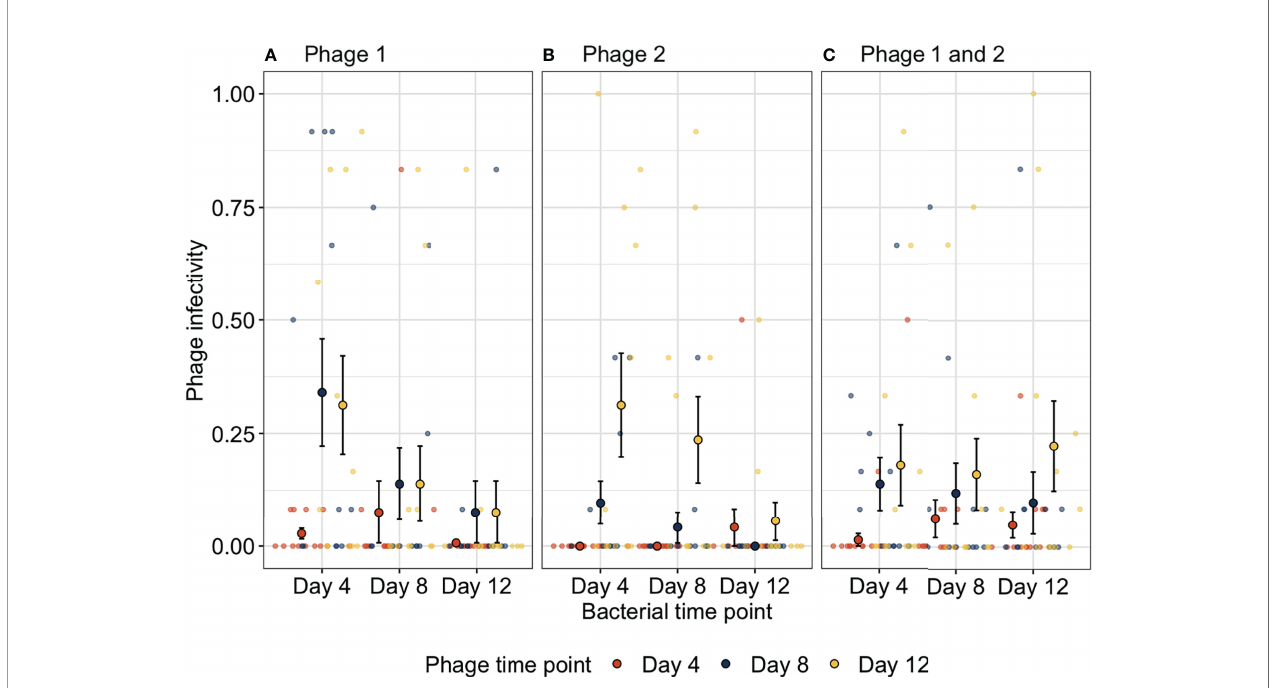
FIGURE 2 | Changes in phage infectivity to bacteria isolated from three different time-points over bacteria-phage coevolution. In the presence of (A) strain one or (B) strain two, bacteria coevolved with phage with increasing bacterial resistance and phage infectivity through time (arms-race coevolution). In contrast, when (C) both phage genotypes were together, phage infectivity increased through time; however, bacteria did not reciprocally increase in resistance indicating a lack of coevolution. Small points indicate the proportion of bacterial clones infected within a single treatment replicate. Large points represent the means of phage infectivity for phage isolated and tested against bacteria from different time-points. The bars show the ± SEs. Phage 1, P1; Phage 2,